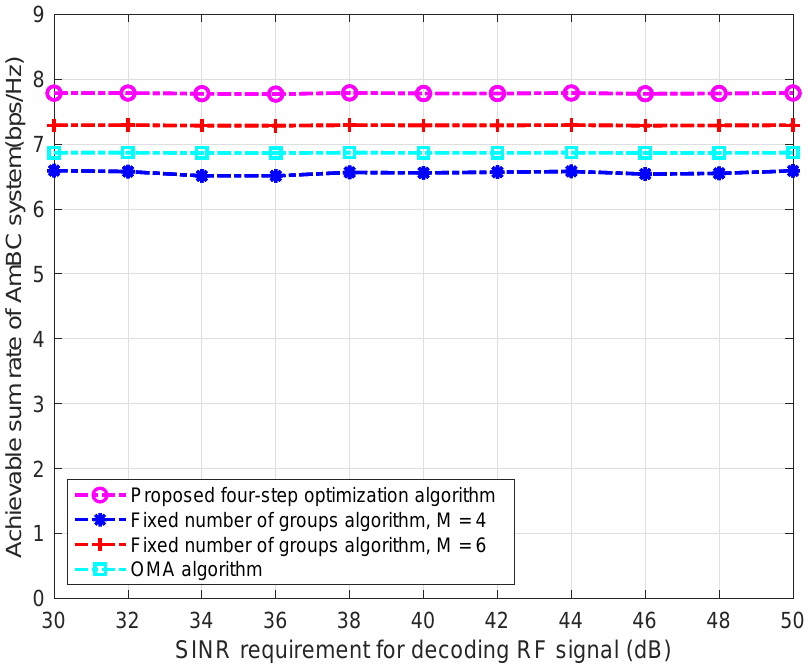
Figure 3. ASR vs. the SINR requirement for decoding RF signal.